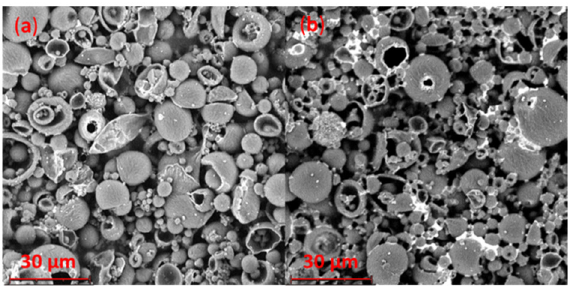
Figure 9. SEM micrographs of microparticles exposed to the in vitro drug release studies, obtained at 2350× magnification: ( a ) aRB-PCL; ( b ) bRB-PCL.